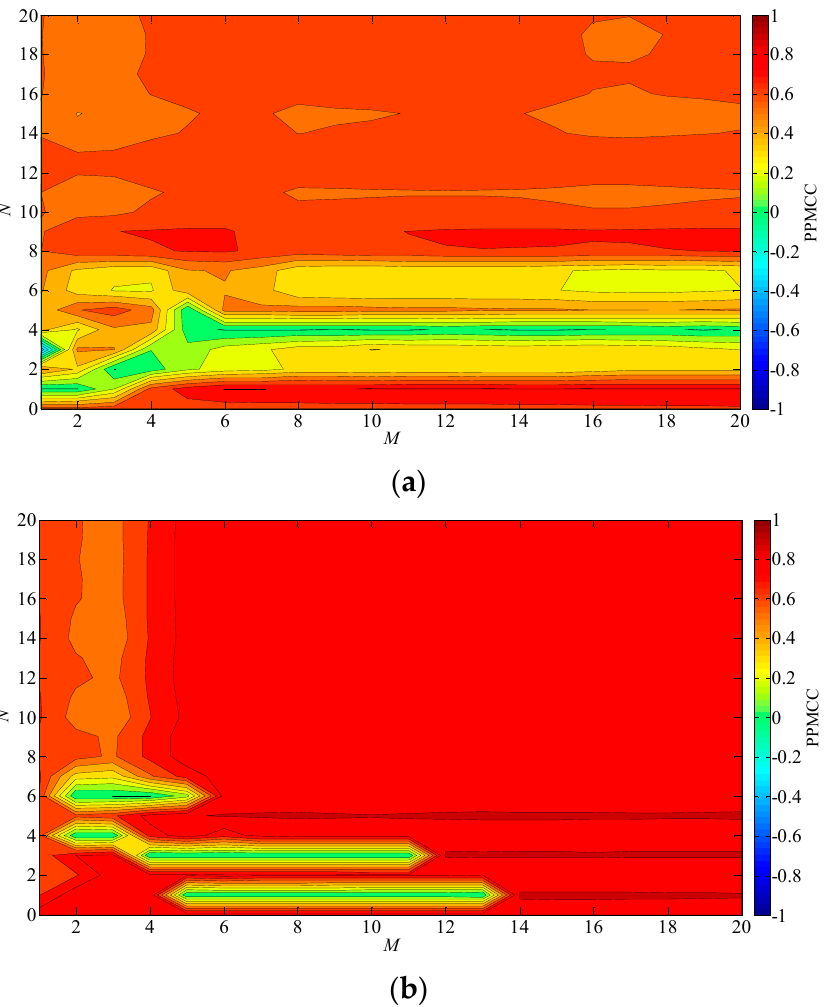
Figure 5. PPMCC contour plots using estimated displacement from measured acceleration: ( a ) lateral direction; ( b ) vertical direction.